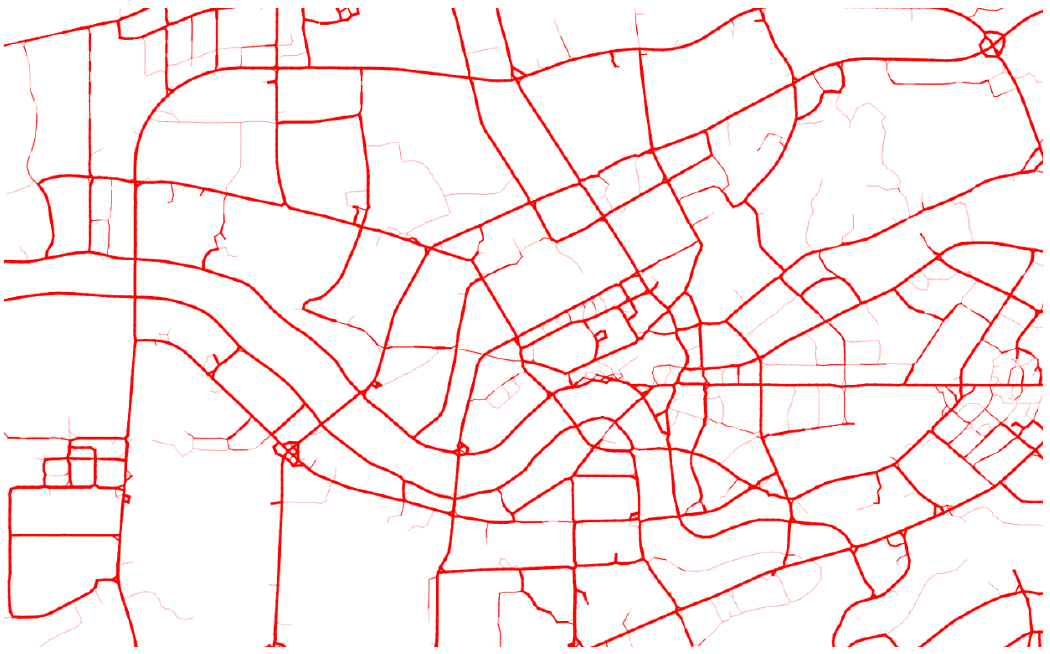
Figure 15. Using line segment thickness to distinguish the number of occurrences of connecting segments.